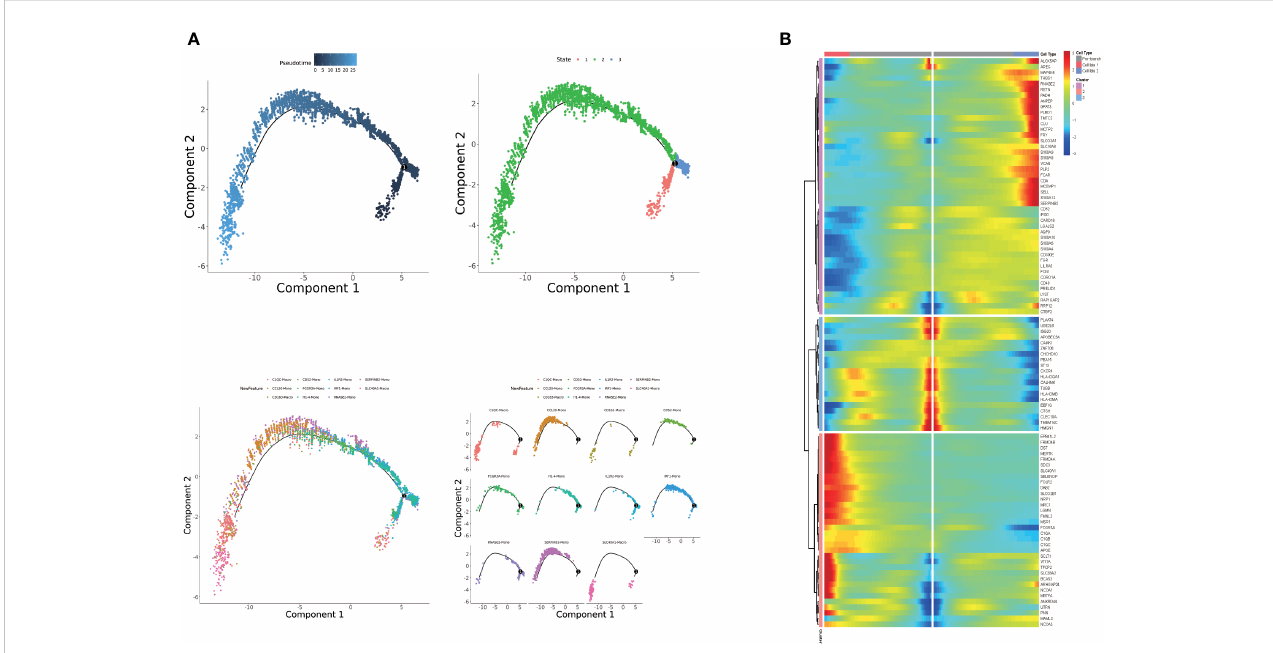
FIGURE 3 (A) Pseudotime analysis of monocyte and macrophage subpopulations. (B) Heatmap displaying the expressions of selected marker genes in monocytes and macrophages that are arranged along the pseudotime